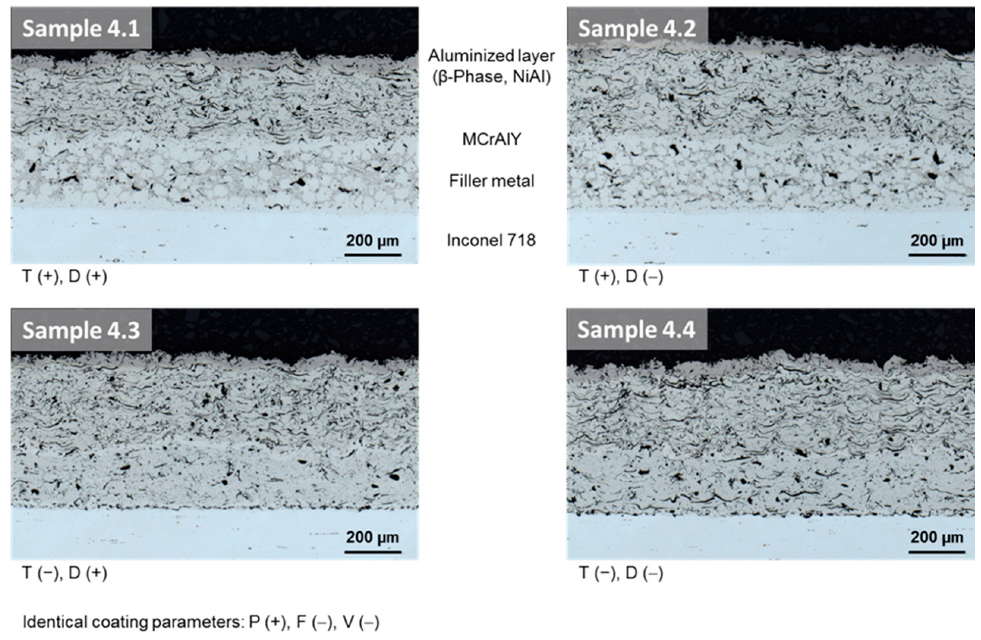
Figure 9. Optical micrographs of cross sections of brazed/aluminized samples (coarse powder; different heat treatment, but identical coating parameters).